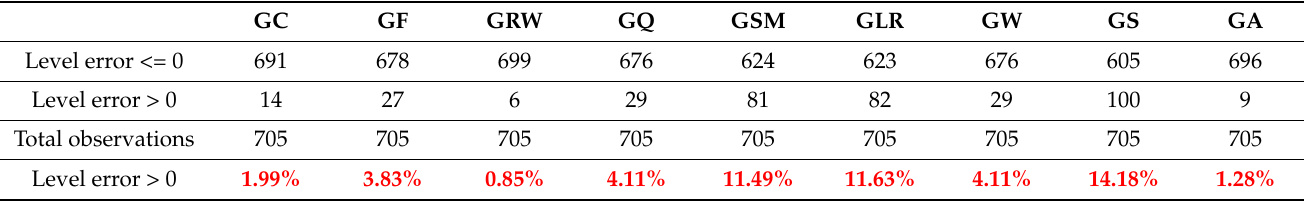
Table 12. Positive differences in the game-level